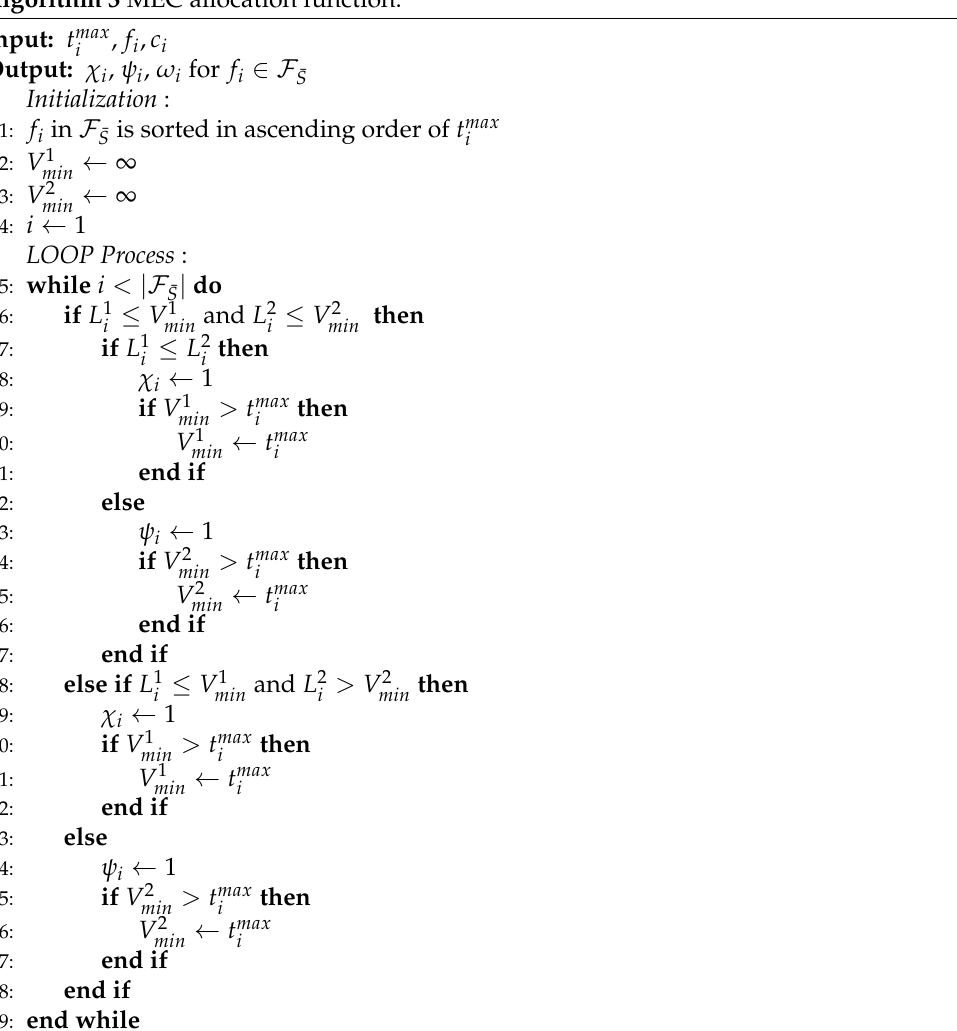
Algorithm 3 MEC allocation